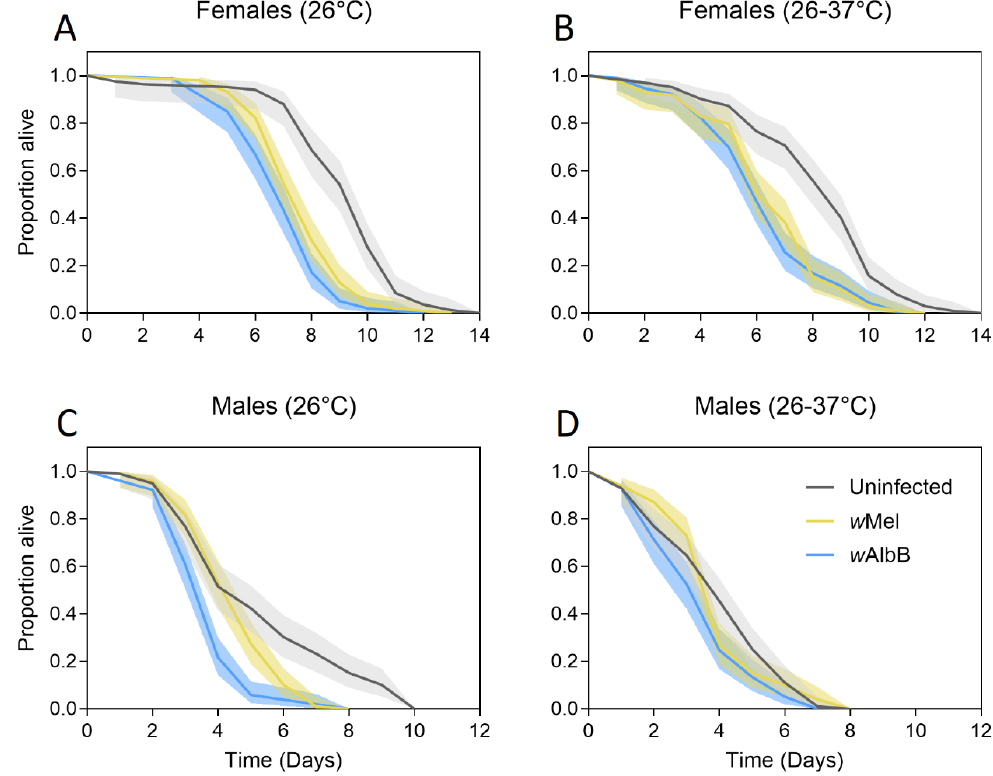
Figure 1. Adult starvation tolerance of female ( A , B ) and male ( C , D ) Ae. aegypti that were reared at either 26 °C ( A , C ) or 26 – 37 °C ( B , D ). Mosquitoes were either uninfected (gray lines) or infected with the w Mel Wolbachia strain (yellow lines) or the w AlbB Wolbachia strain (blue lines). Solid lines represent the proportion of adults alive each day, while shaded areas are 95% confidence intervals.